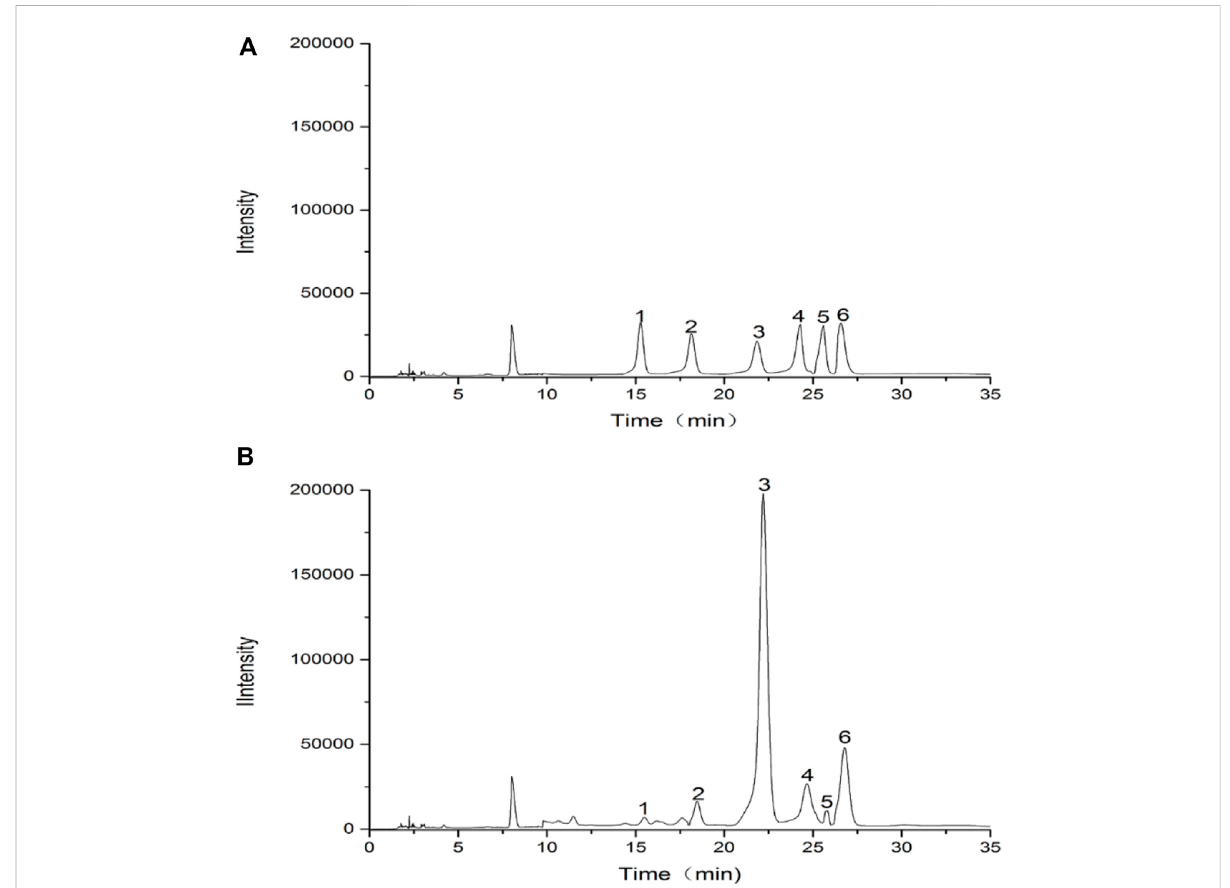
FIGURE 5 HPLC chromatograms of hydrolysed polysaccharide derivatives and mixed monosaccharide standard derivatives. (A) HPLC chromatogram of monosaccharide standards; (B) HPLC chromatogram of RFP. (1) rhamnose, (2) D-galacturonic acid, (3) D-glucose, (4) D-galactose, (5) xylose, (6)